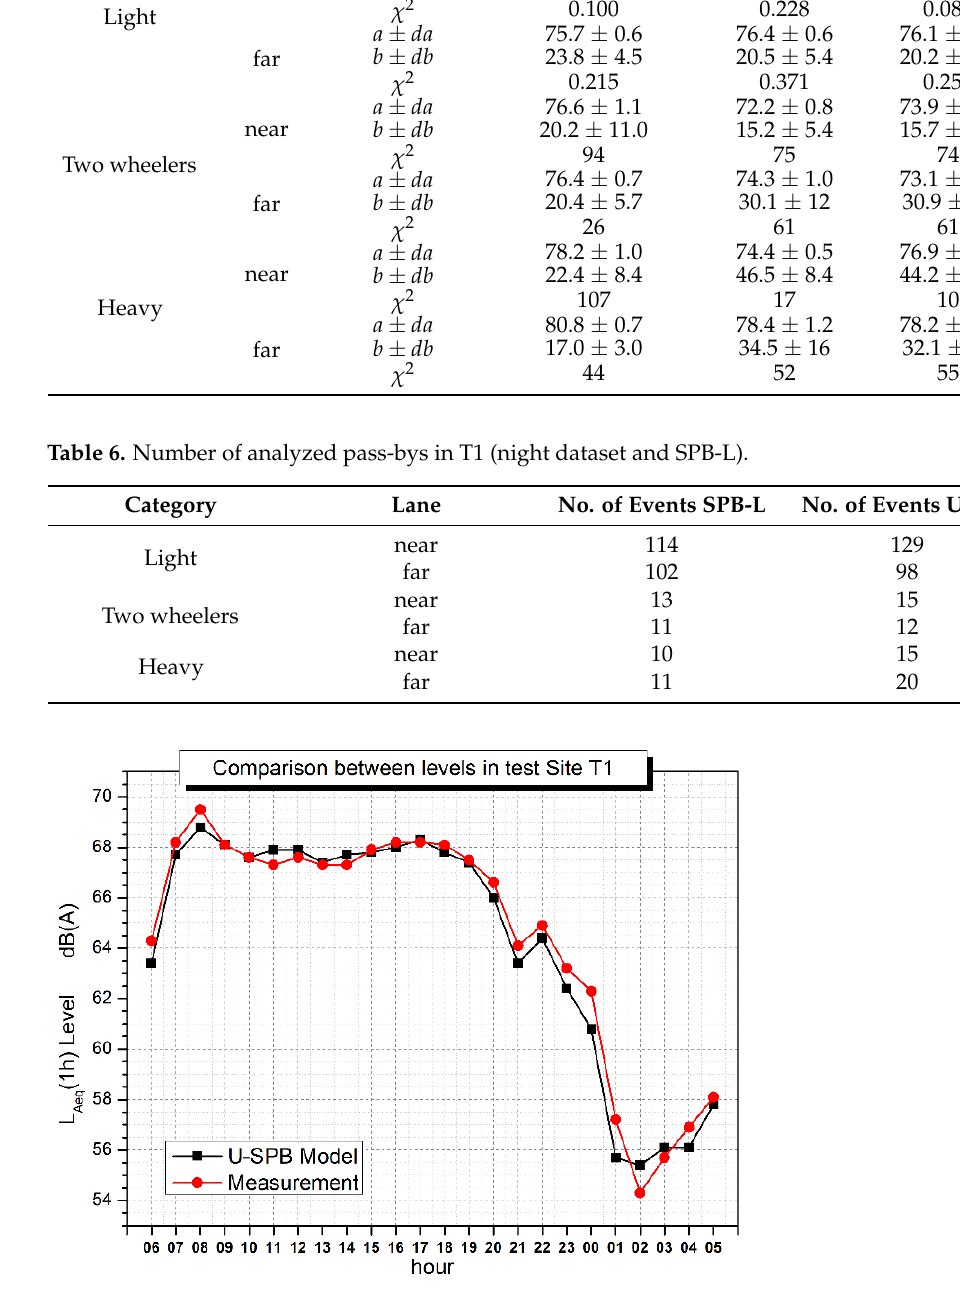
Figure 6. U-SPB L Aeq,h model and measured L Aeq,h comparison in T1.